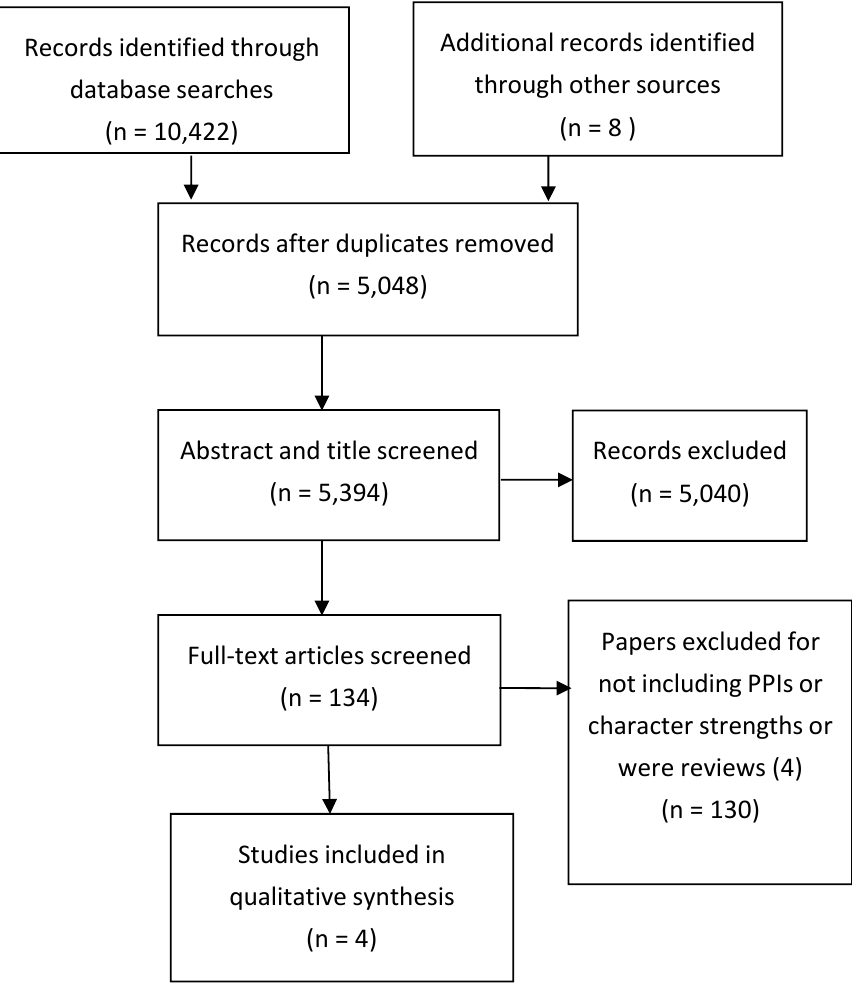
Figure 1 Study selection process [17]. Figure 1. Study selection process